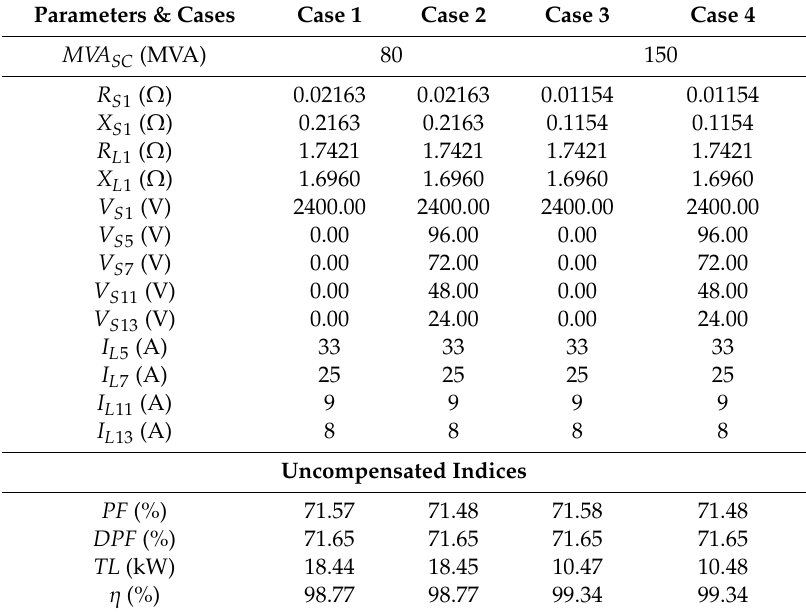
Table 1. Industrial plant parameters and source harmonics.